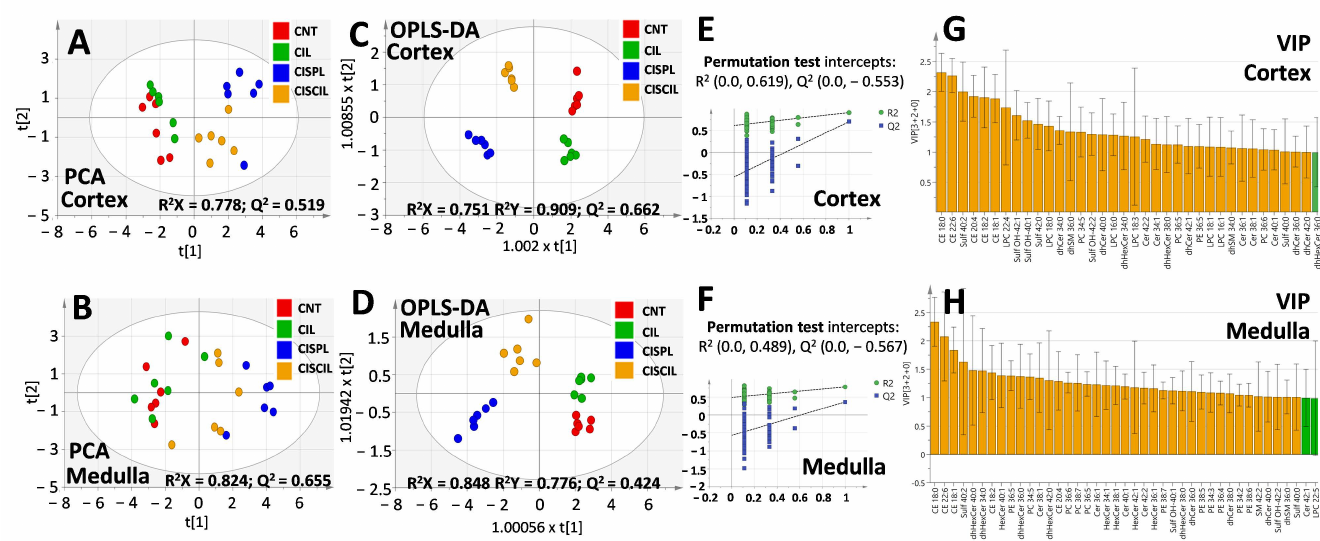
Figure 8. Multivariate analysis of cortex and medulla lipids for simultaneous comparison of CNT, CIL, CISPL, and CISCIL groups. Principal component analysis (PCA) scores plots for ( A ) cortex lipids and ( B ) medulla lipids. Orthogonal partial least squares discriminant analysis (OPLS-DA) score plots for ( C ) cortex and ( D ) medulla lipid variables. Here, 100 cycle permutation tests were done for OPLS-DA models validation using ( E ) cortex and ( F ) medulla lipids. Variable importance in projection (VIP) scores, for the OPLS-DA models, higher than 1 are presented in orange for most relevant ( G ) cortex and ( H ) medulla lipids influencing groups